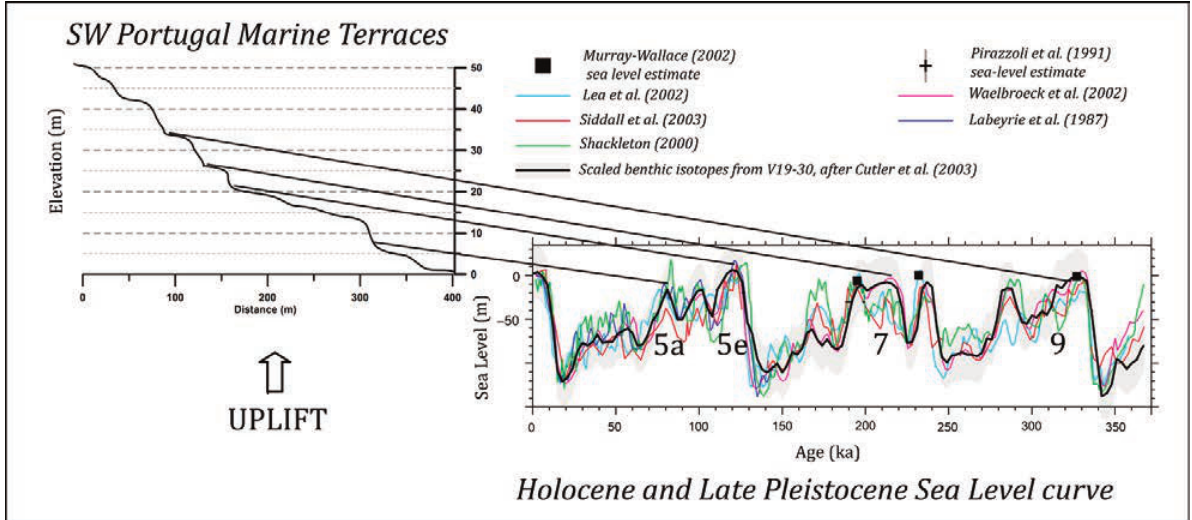
Figure 10. Schematic southwest Portugal marine terraces correlation with paleo-sea level estimates compiled from different studies: MIS 5a, MIS 5e, MIS 7, MIS 9 interglacials are identified (adapted from Siddall et al.